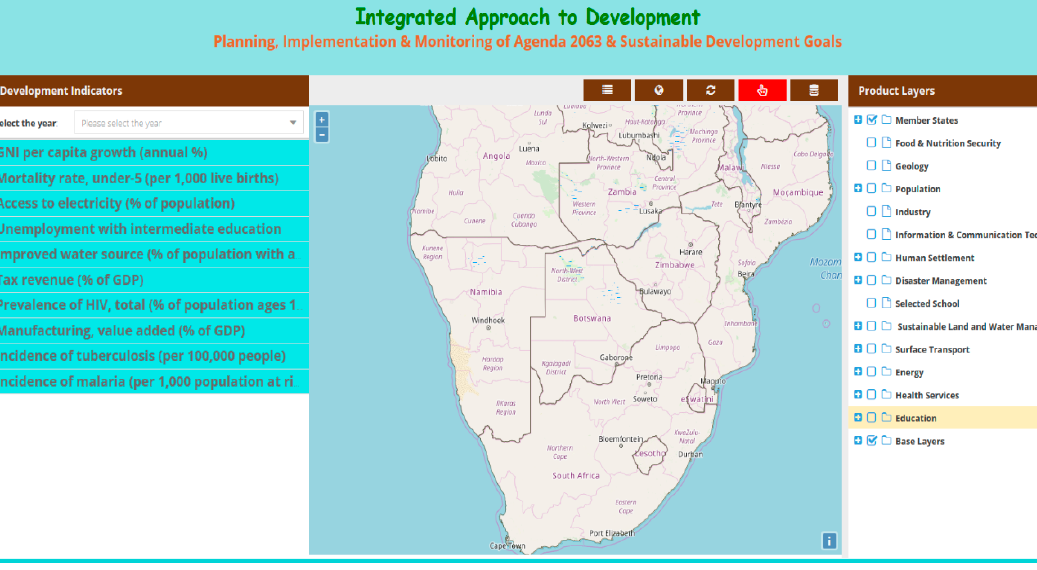
Figure 5. Base layers can be viewed on the maps and overlaid for visual and quantitative analysis.